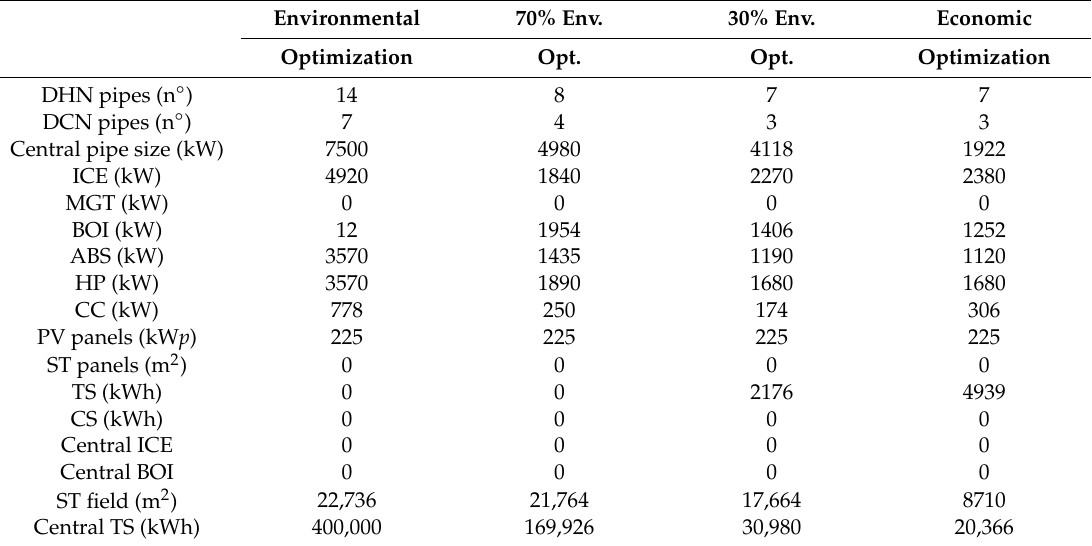
Table 15. Optimal configurations of the complete distributed generation solutions. Environmental 70% Env. 30% Env. Optimization Opt.